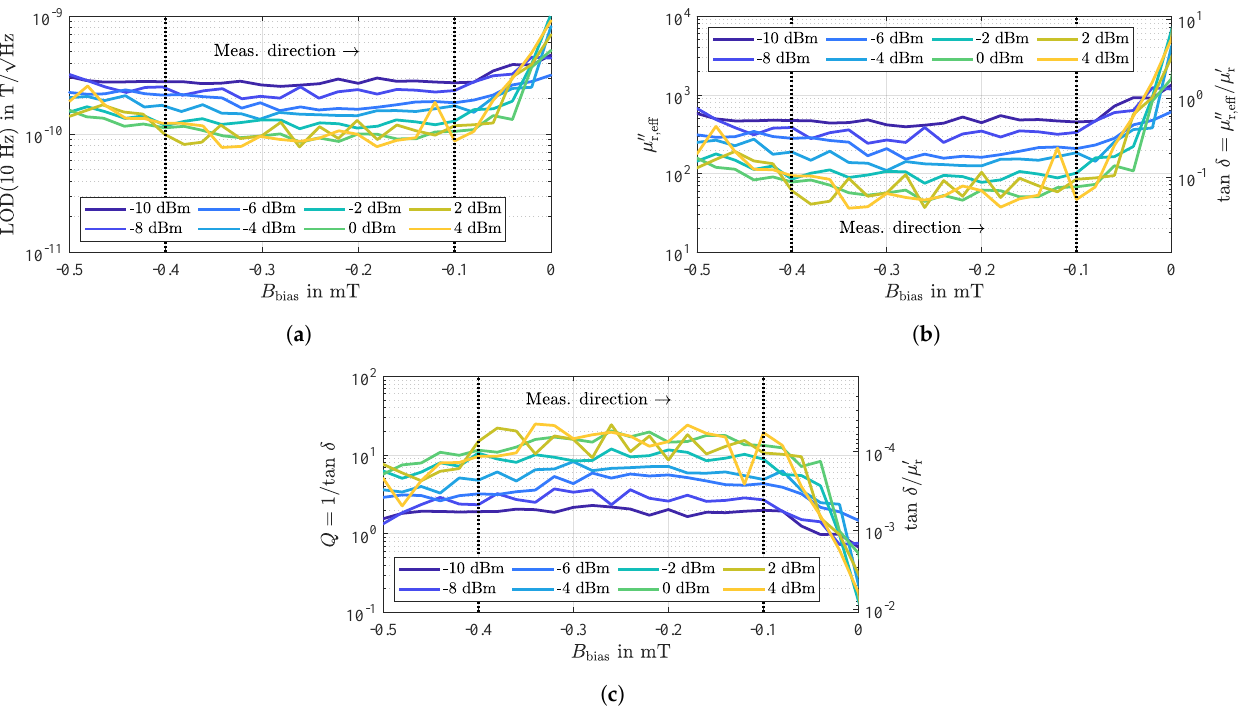
Figure 15. Measured limit of detection at an exemplary frequency of 10Hz ( a ) and determined magnetic key figures ( b , c ) on the basis of Equation (25). On one hand, the results confirm the detectivity’s independence of the phase sensitivity and constant magnetic properties in a wide range of magnetic bias flux densities (dotted lines). On the other hand, a significant dependence of the magnetic properties, and thus the sensor performance, on the input power level is revealed. The underlying measurements were performed after a previously performed magnetic saturation in negative